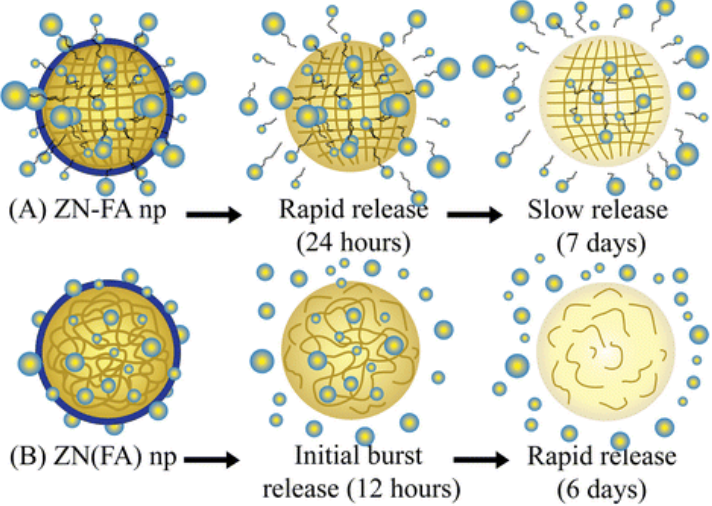
Figure 3. Release mechanisms of FA from NPs: covalently linked ( A ) and physically entrapped ( B ). Reprinted with permission from [69]. Copyright 2017 Springer.